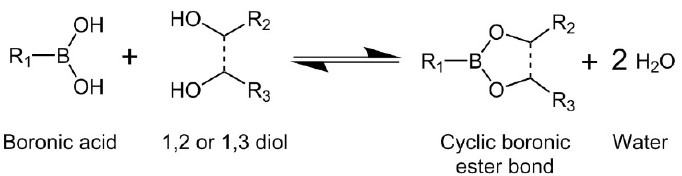
Figure 3. Formation of reversible boronic esters bond through reactions between boronic acids and diols.